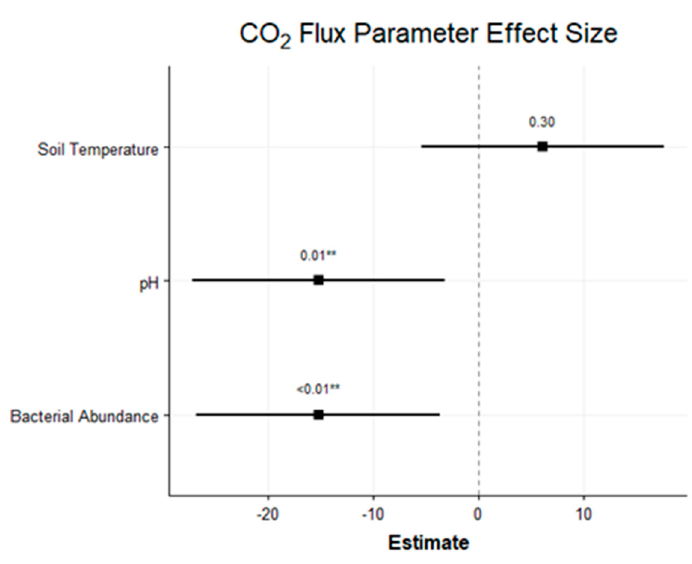
Figure 4. CO 2 flux within treatments.